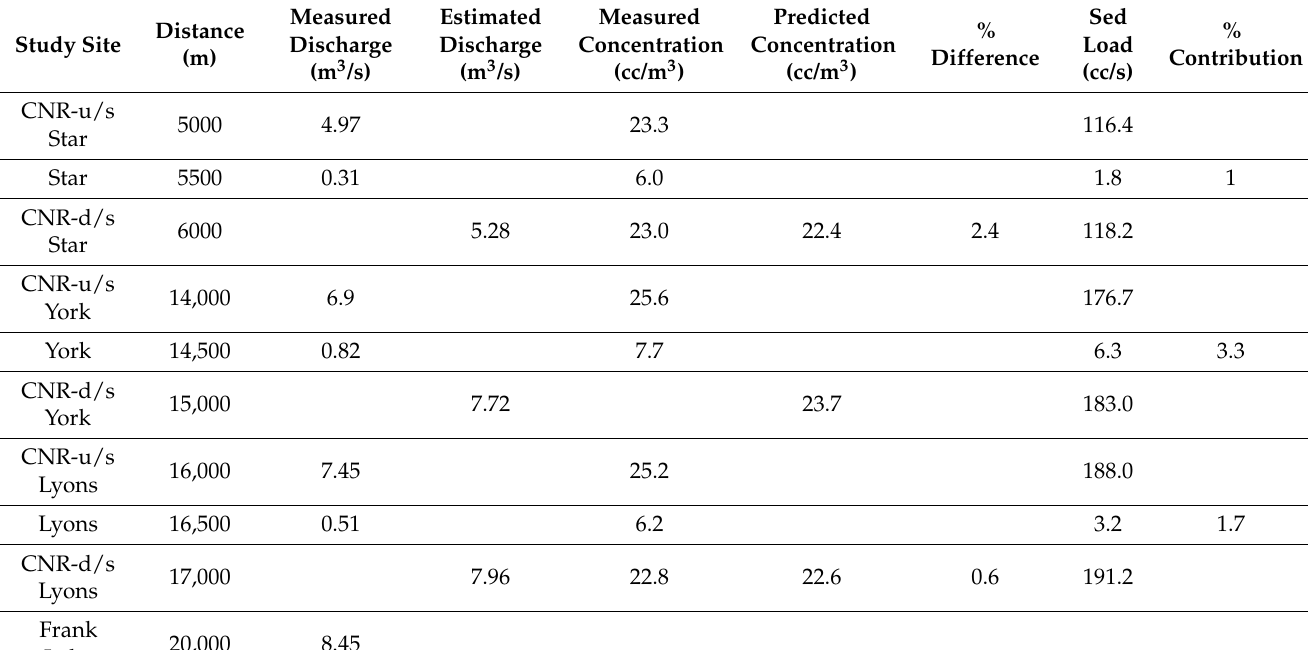
Table 2. Summary of suspended sediment measurements in the upper Crowsnest River (CNR) and tributaries (May 2015). Study sites relate to those shown in the schematic in Figure